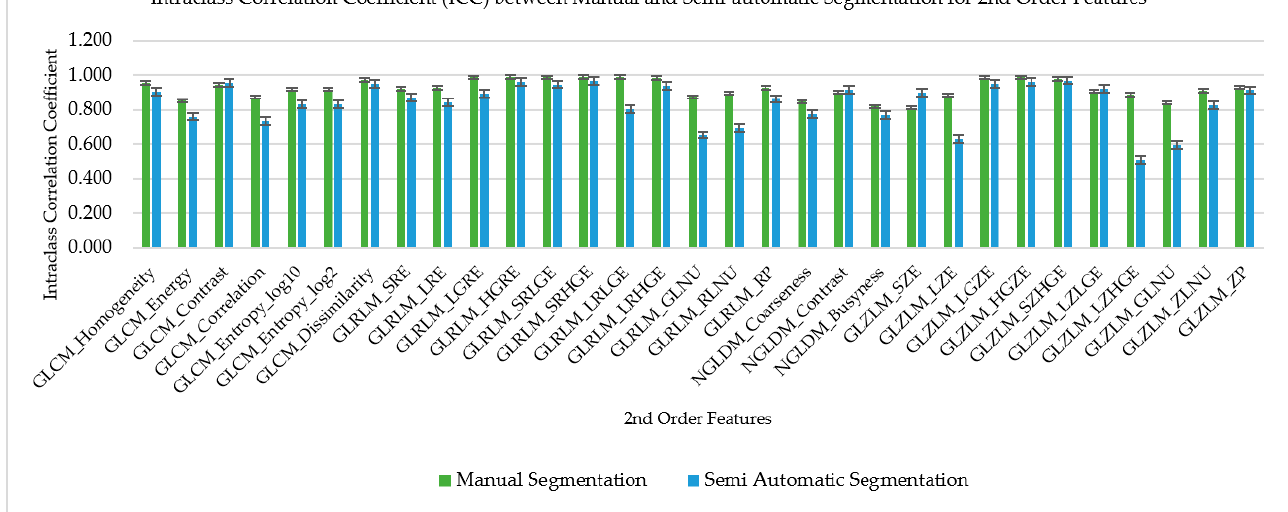
Figure 9. Intraclass Correlation Coefficient (inter-CC) between manual and semi-automatic segmen- tation for 2nd order features to compare its repeatability..